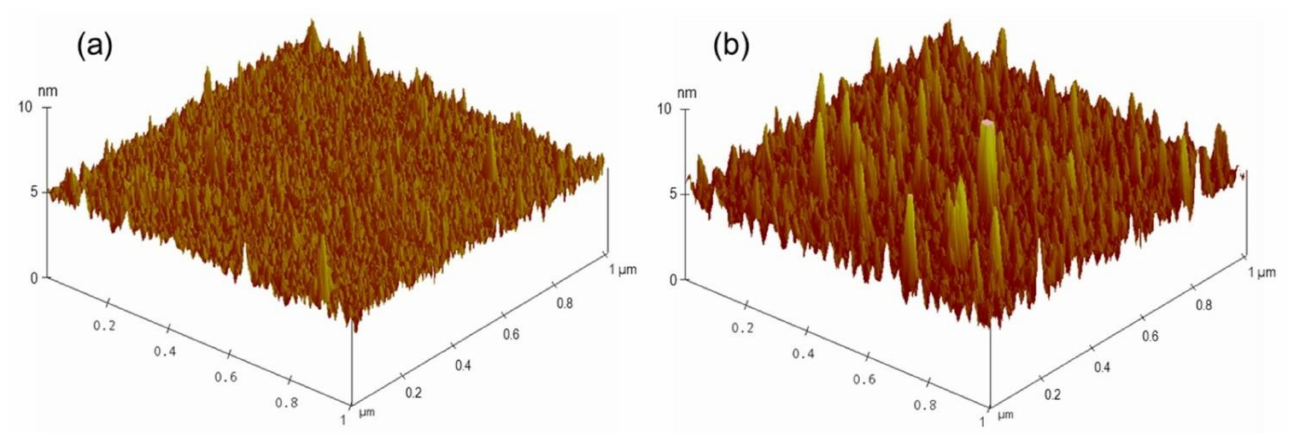
Figure 4. Three-dimensional AFM images of substrates immobilized with 200 nM AMX aptamer ( a ), and upon incubation of 800 nM amoxicillin ( b